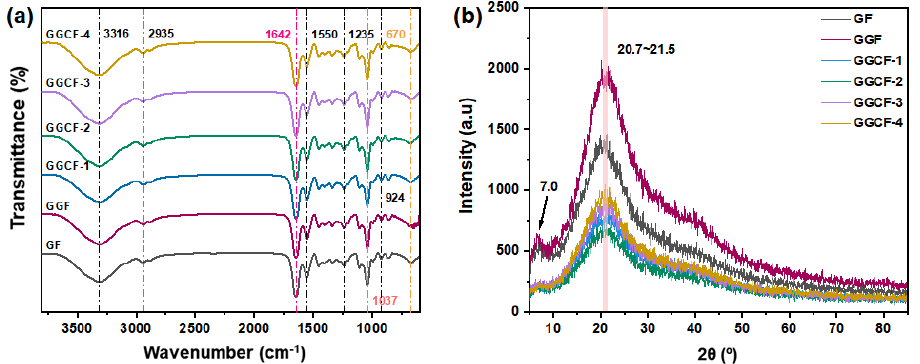
Figure 2. FTIR ( a ) and XRD ( b ) spectra of gelatin-based films (GBFs).